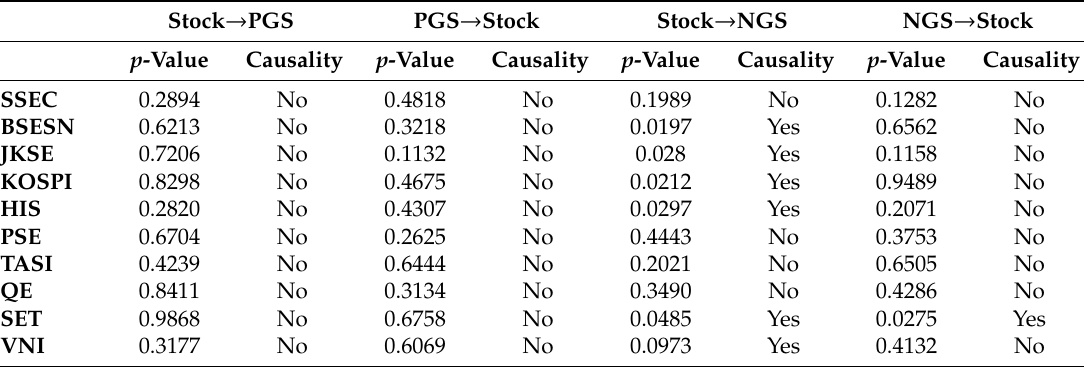
Table 4. Granger causality test for the relationship between gold price shocks and stock returns. Stock → PGS PGS →